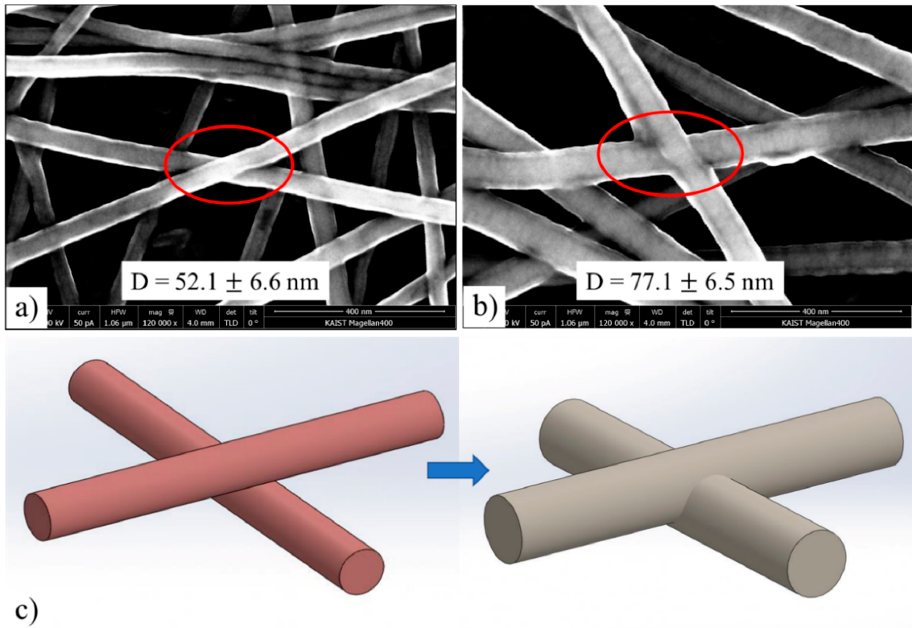
Figure 4. ( a ) CuNWs before, ( b ) after PC plating of nickel, ( c ) schematic of the intersection between two NWs before and after two NWs before and after plating.